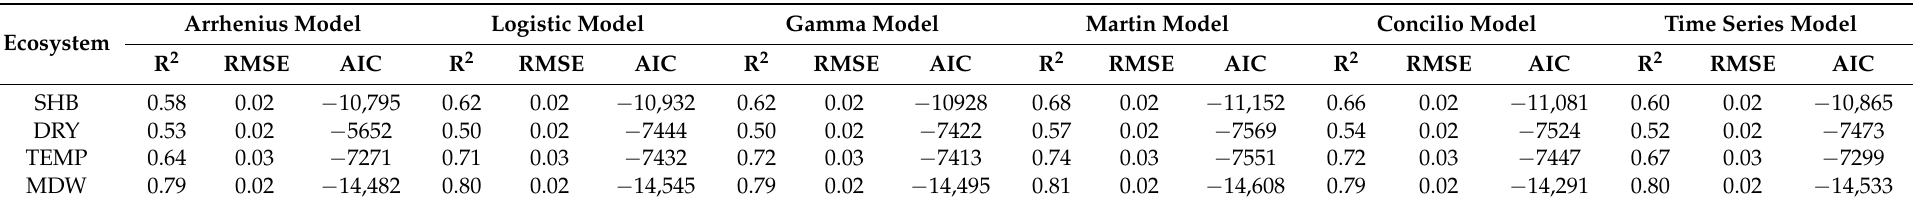
Table 2. Performance of six respiration models based on correlation coefficients of determination (R 2 ), Root Mean Square Error (RMSE), and Akaike information